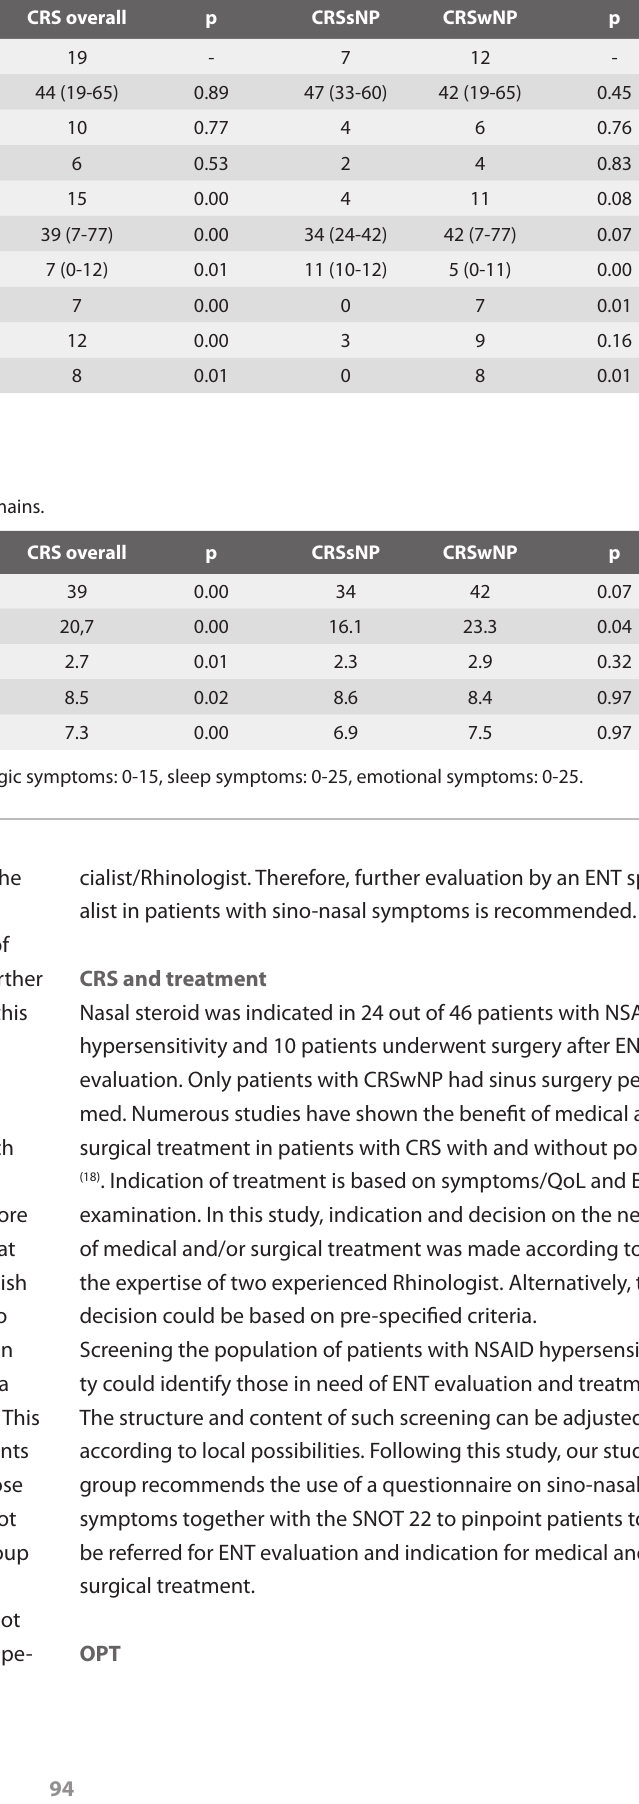
Table 2. Results comparing patients with and without CRS and patients with CRSwNP and CRSsNP (Range).